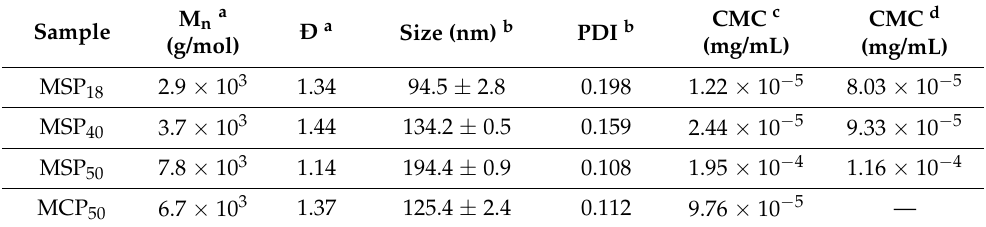
Table 1. Number-averaged molecular weights of copolymers and their properties of micelles.